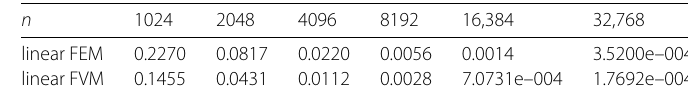
Table 10 The error in the relative discrete L 2 -norm for problem (5.2) with k = 300 n 1024